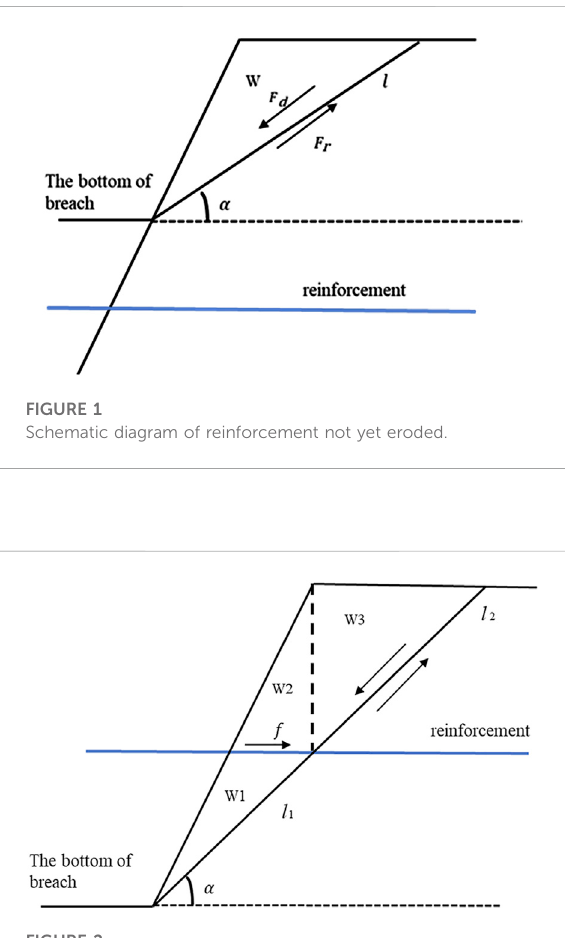
FIGURE 2 Schematic diagram of erosion to reinforcement.